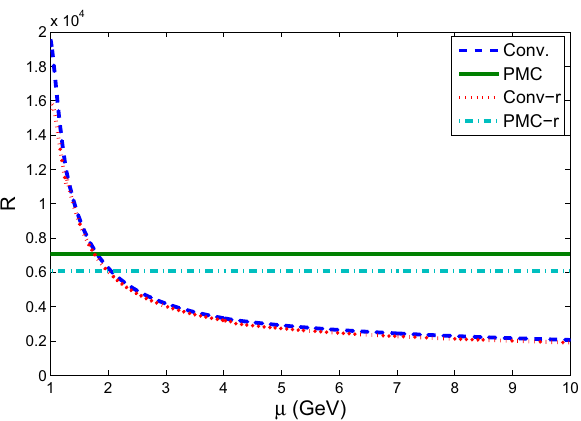
Fig. 1 The ratio R at the NLO level versus the initial choice of μ under the mMOM scheme. m c = 1 . 49 GeV. The symbol “ − r ” stands for relativistic corrections. For conventional scale setting, the sensitivity of μ is very large. After applying the PMC, R is independent to the choice of